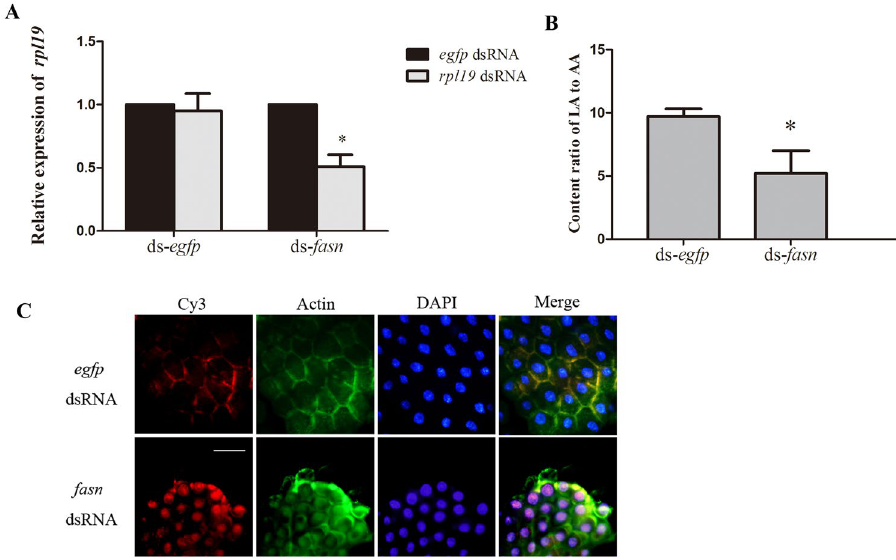
Figure 6. Effect of silencing fasn on the endocytosis of dsRNA. (A) mRNA accumulation of the target gene after secondary exposure in the fasn -silenced Ch flies. (B) The relative content ratio of LA:AA after the initial exposure to ds- rpl19 followed by ds- fasn injection. (C) Subcellular localization of Cy3-labelled ds- rpl19 in midgut tissue of fasn -silenced Ch B. dorsalis flies. The scale bar represents 25 μ m. Normalized target mRNA accumulation is reported relative to mRNA accumulation in the ds- egfp control, which was set to 1. All error bars represent the S.E. of the mean of three independent biological replicates. * indicates a statistically significant difference in rpl19 mRNA accumulation between the feeding ds- rpl19 group and the control ds- egfp group (P < 0.05, Student’s t-test).